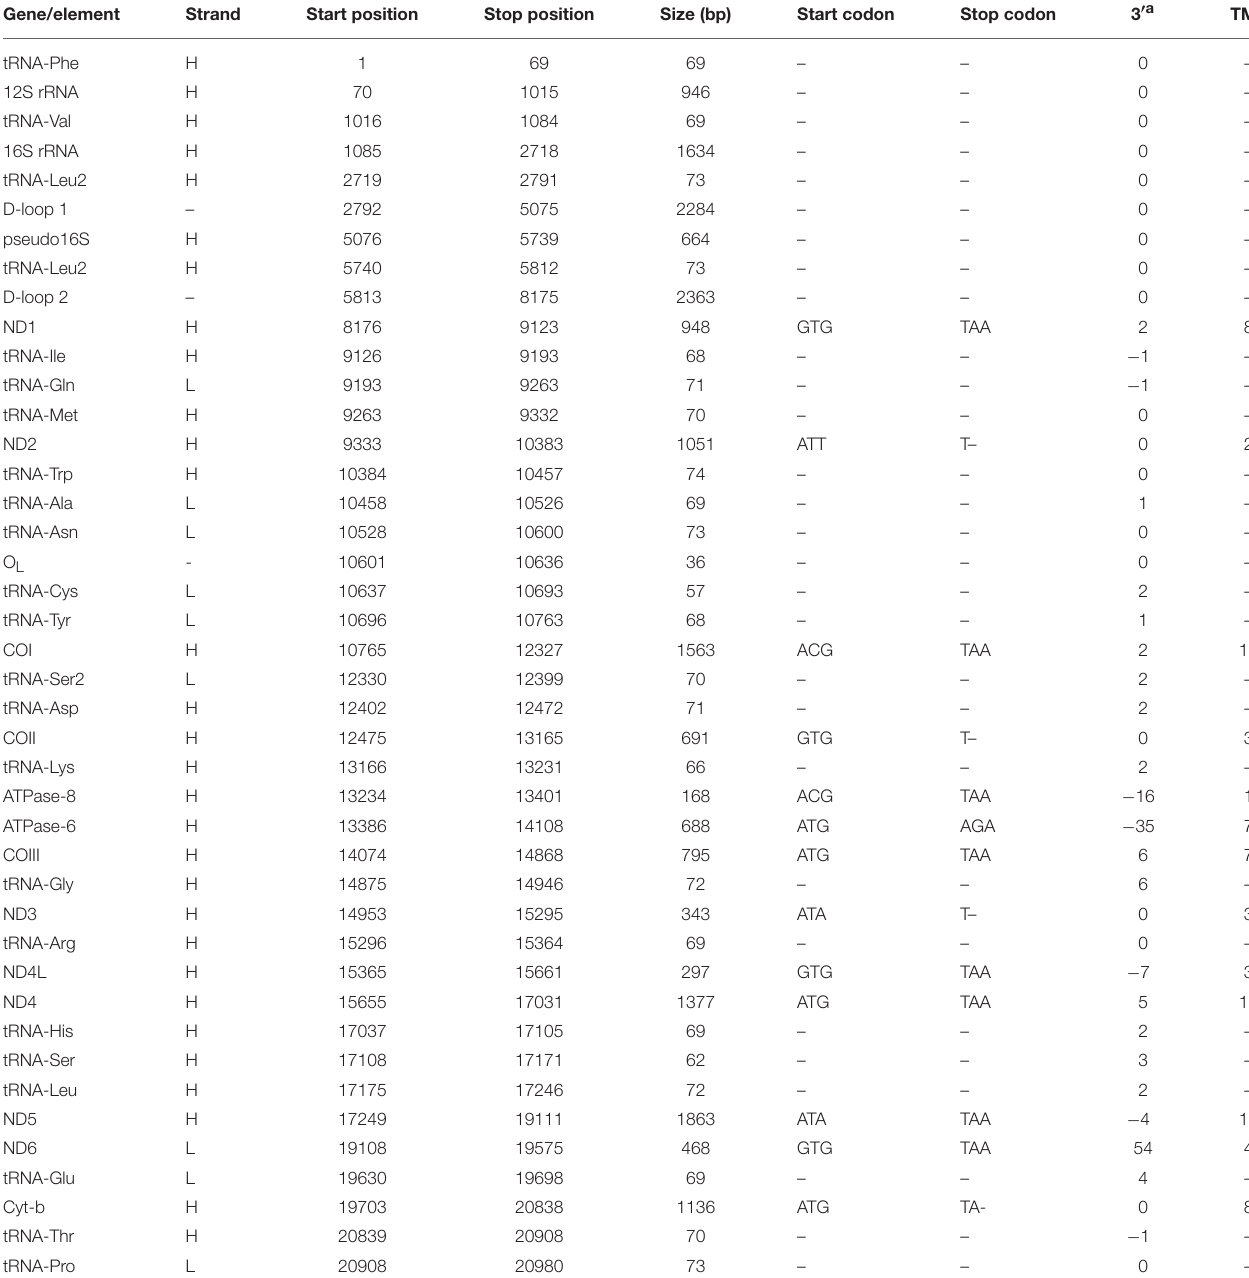
TABLE 2 | A. limnaeus mitochondrial feature